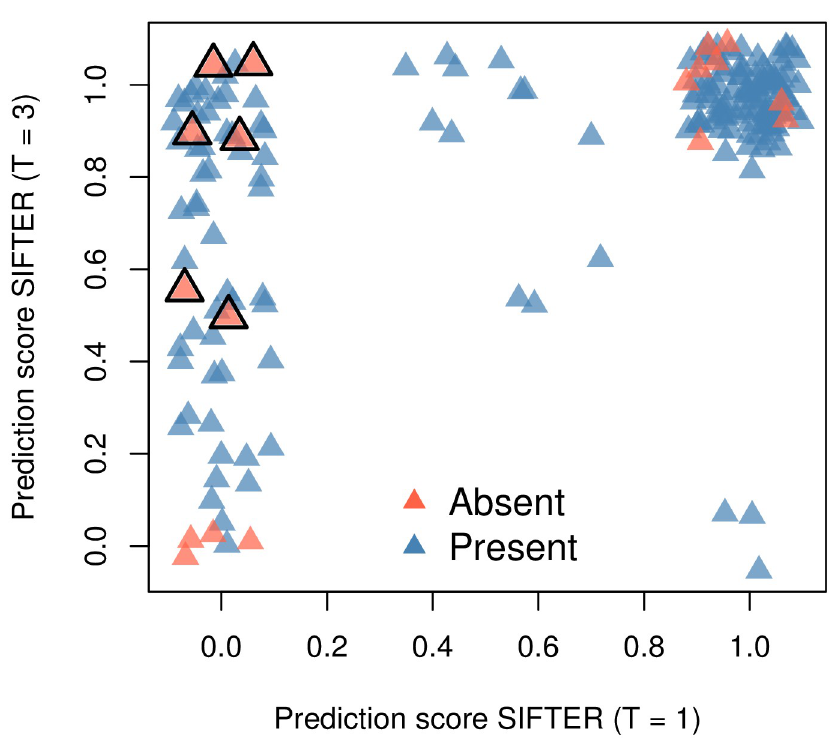
Fig 14. Scatter plot comparing all 184 prediction scores between SIFTER with truncation level one, and SIFTER with truncation level 3. Red triangles correspond to negative annotations, while blue triangles mark positive annotations. The six negative annotations with a black border highlight observations that were correctly classified with truncation one, but were misclassified using truncation level 3. The coordinates were jittered to avoid overlapping.